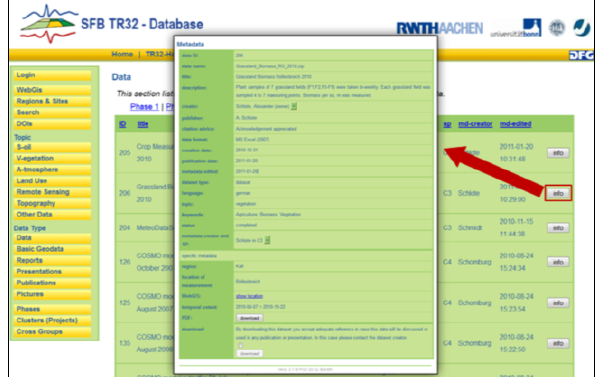
Figure 4. Request on type ‘data’ with metadata info